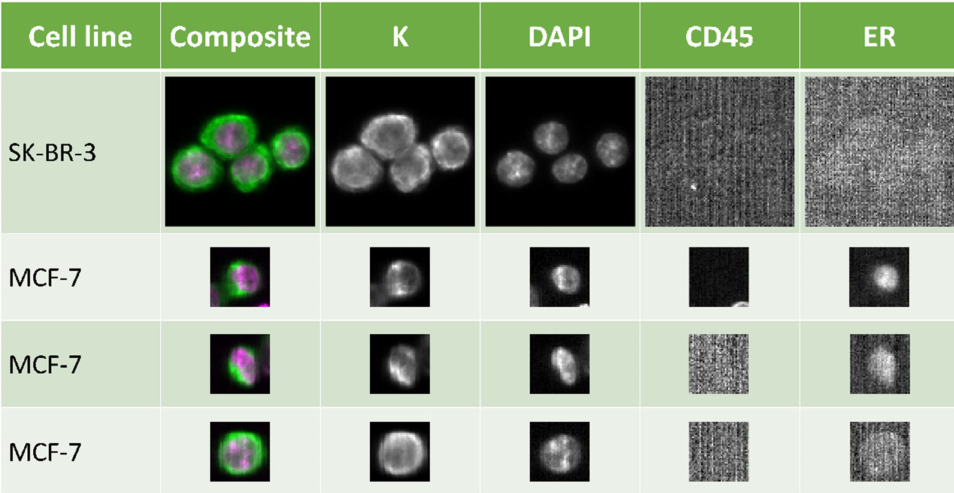
Figure 1. ER expression detected in breast cancer cells by the CellSearch System. SK-BR-3 (top row) is an ER-negative cell line and was used as a negative control. MCF-7 is ER-positive and exam- ples are given for strongly positive, (second row), weakly positive, (third row), and (bottom row) nuclear staining. Standard selection markers of the CellSearch System for tumor cells are keratin (K) and DAPI, whereas CD45 is used as an exclusion marker. Automatic low signal compensation leads to high background signal seen in CD45 and ER-negative scans. Pictures were taken using 10 ×